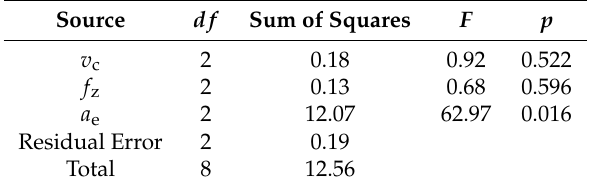
Table 12. Analysis of variance for S/N ratios of ball end milled vertical surfaces, R 2 = 98.47%.